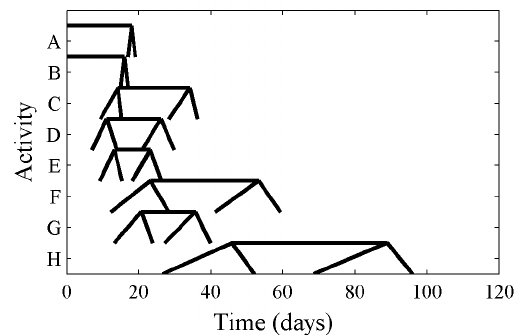
Fig. 9. Fuzzy Gantt Chart-2D with overlap